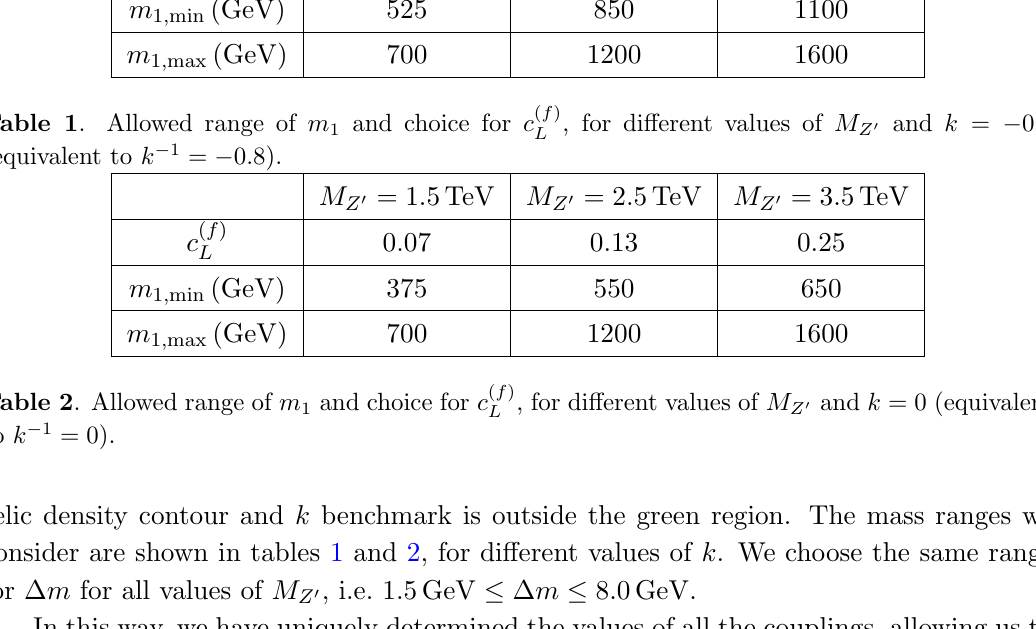
( f ) , for di(cid:11)erent values of M Z 0 and k = L